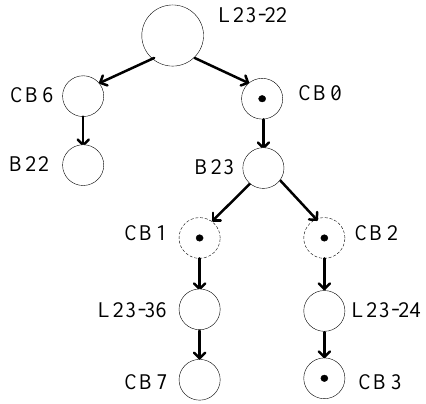
Figure 6. The information connection tree of L23-22.